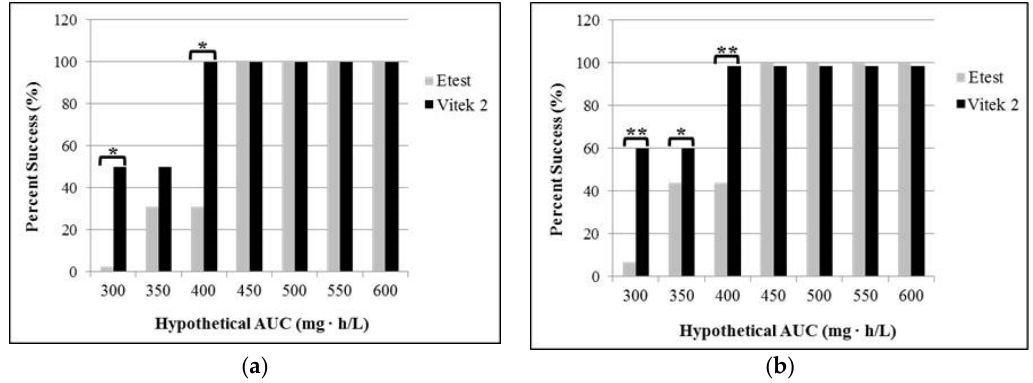
Figure 3. Frequency distribution of vancomycin area under the serum concentration time curve to minimum inhibitory concentration (AUC/MIC) ratio targeted attainment for each assumed AUC ( a ) in MRSA; ( b ) in MSSA. The asterisk mark indicates statistical significance. ** p < 0.001; * p < 0.05 for McNemar’s test. Abbreviations: AUC, area under the serum concentration time curve.